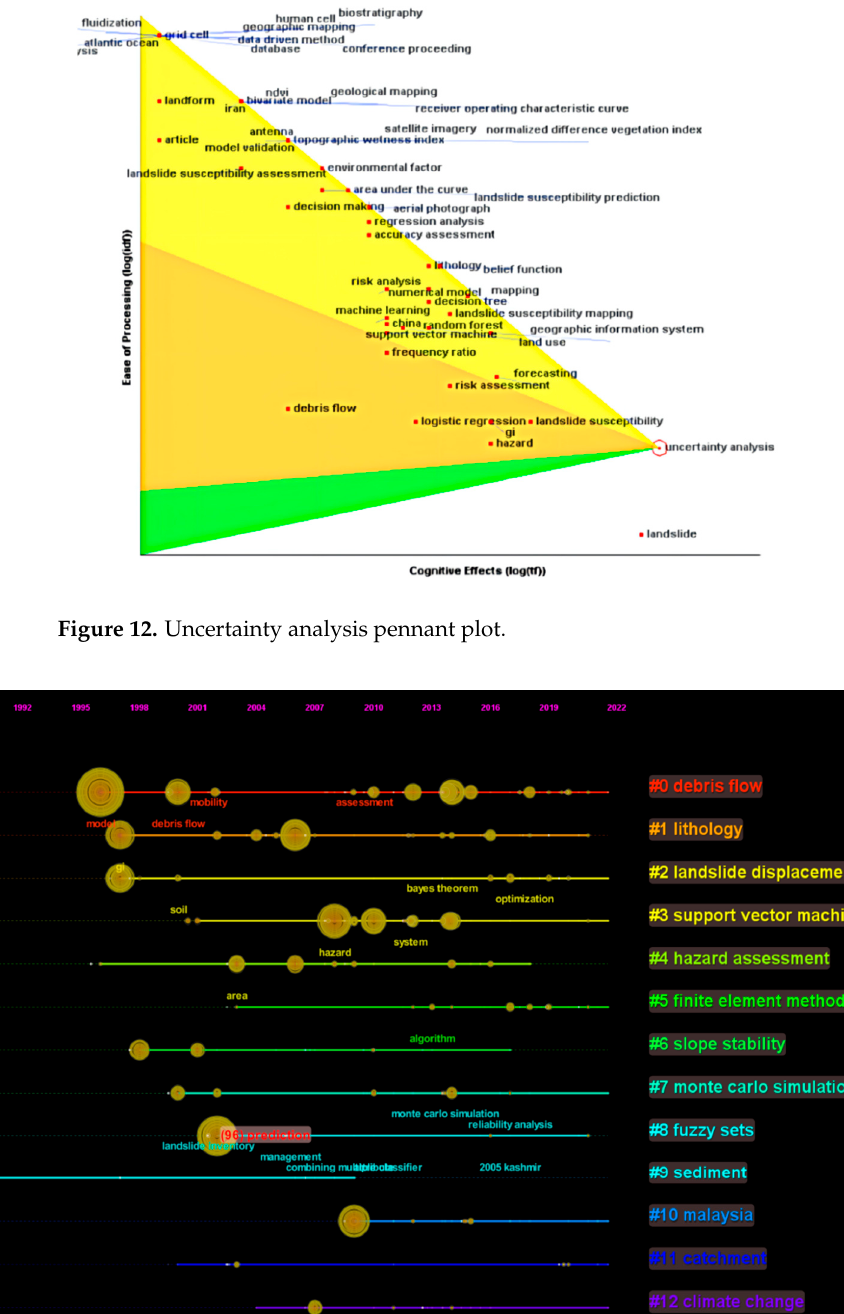
Figure 11. Keyword mutation analysis.